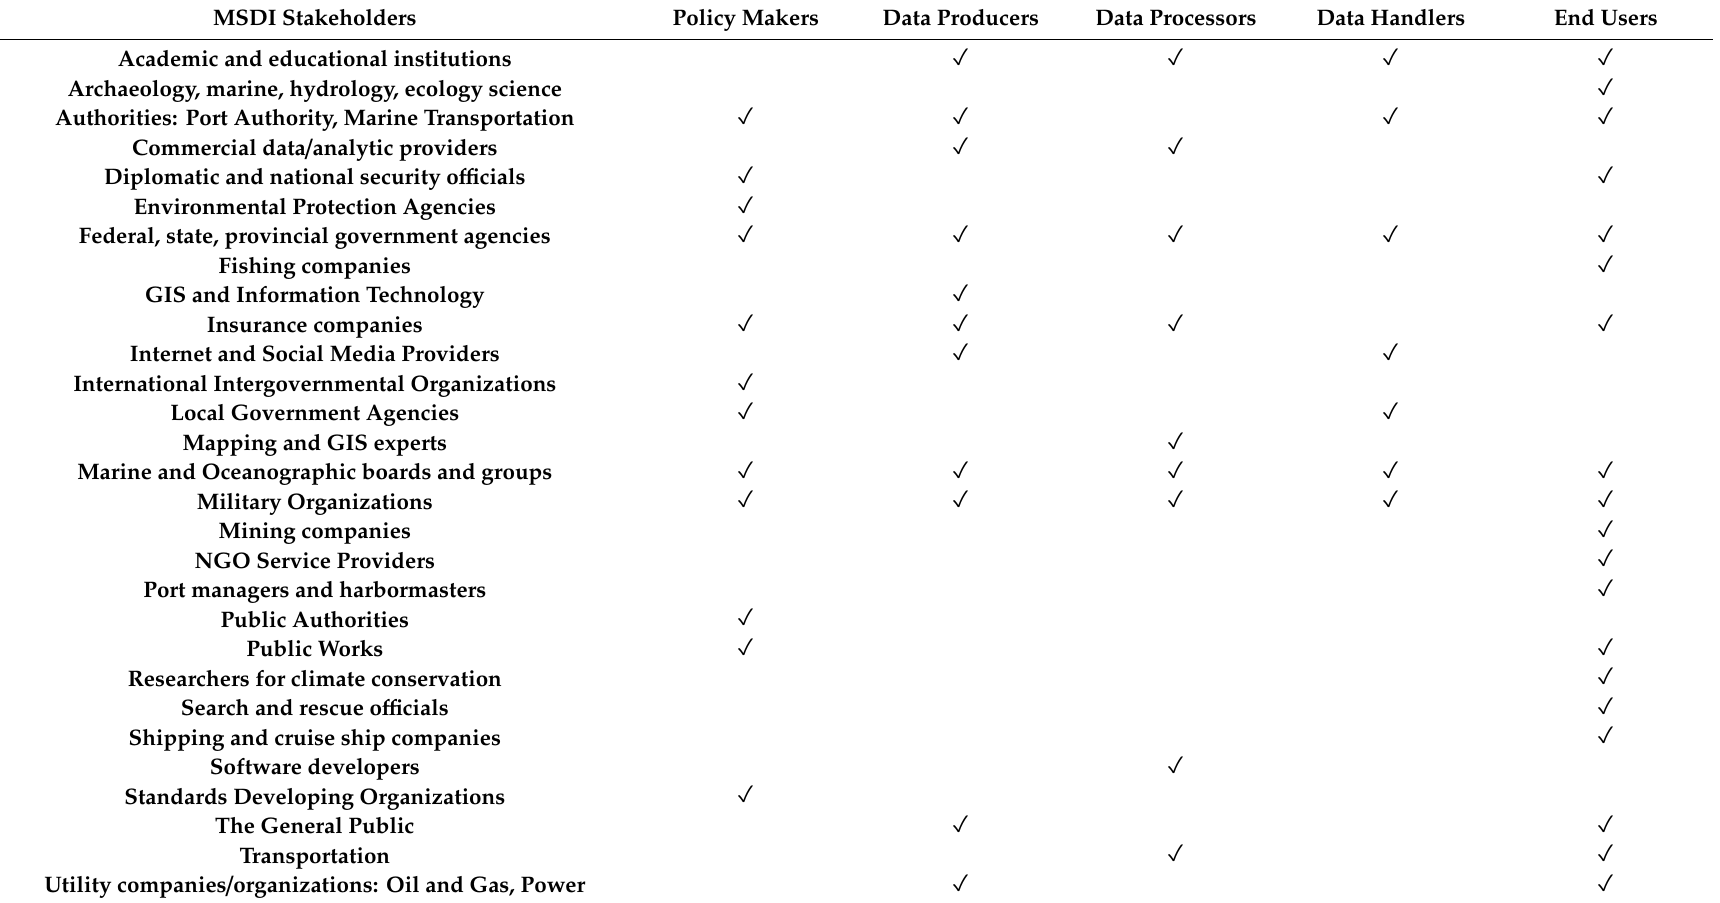
Table 5. Marine SDI stakeholders and potential uses. Adapted from reference [41].